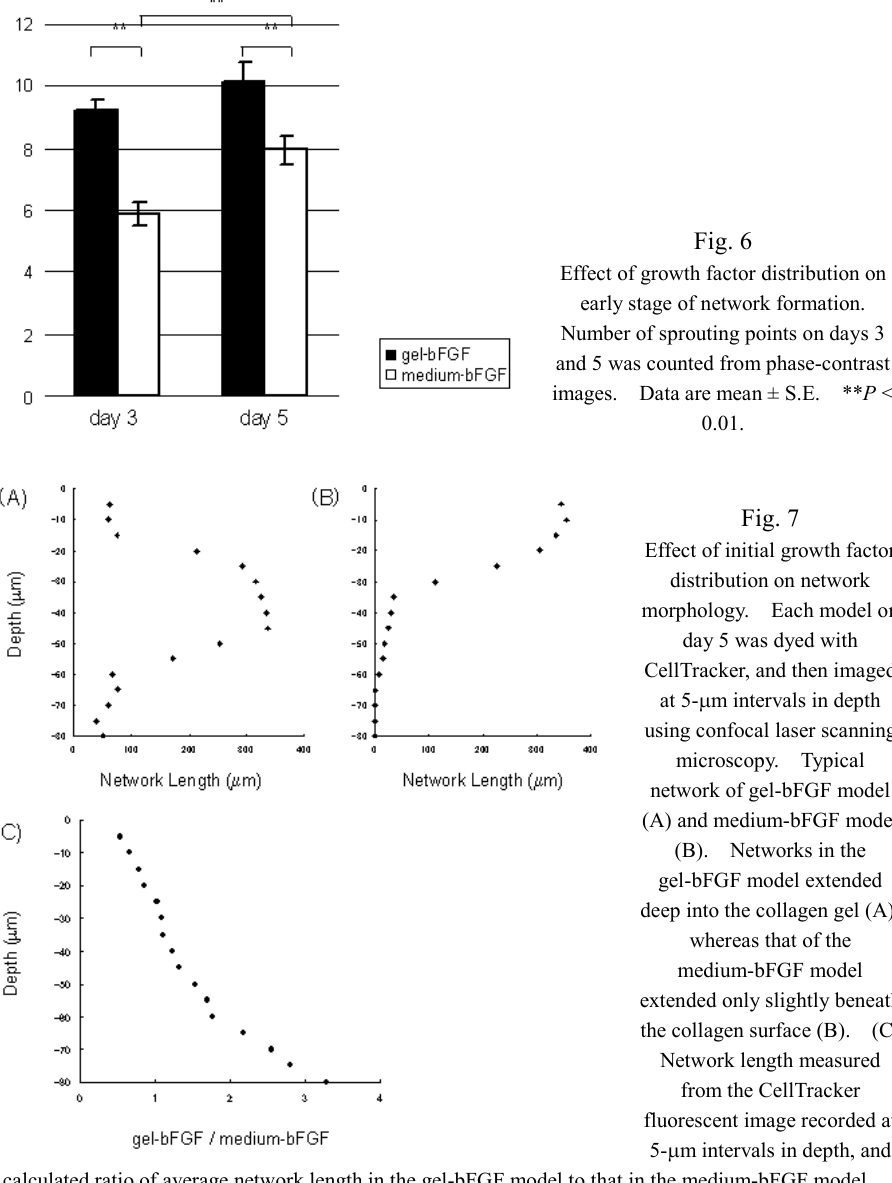
Fig. 6 Effect of growth factor distribution on early stage of network formation. Number of sprouting points on days 3 and 5 was counted from phase-contrast images. Data are mean ± S.E. ** P < 0.01.